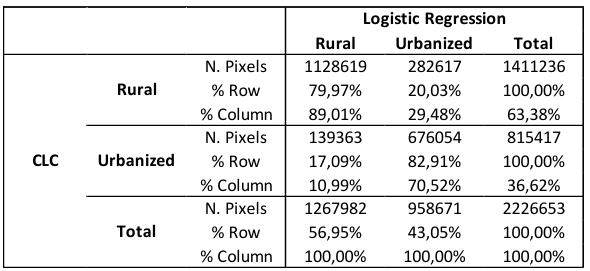
Table 5. Urbanized Land (FROM-GLC) vs Luojia 1-01 (Shenzhen)